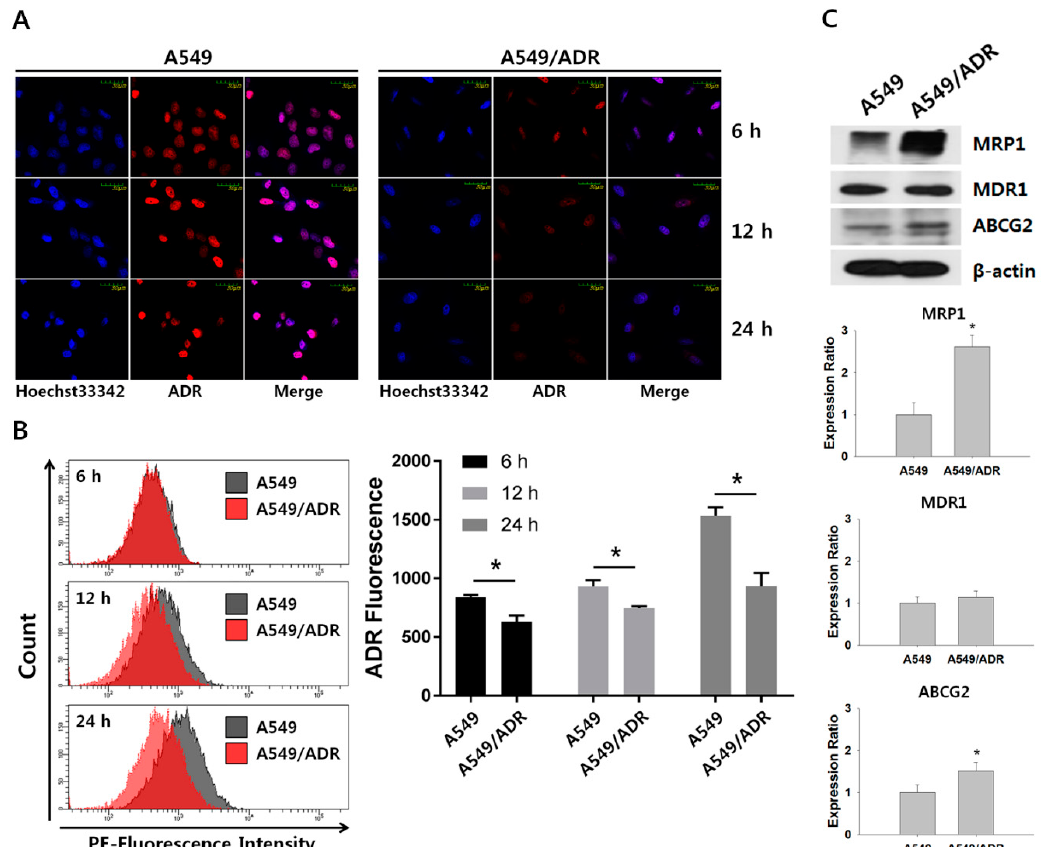
Figure 4. Decrease in intracellular ADR accumulation in A549/ADR cells. ( A ) Representative images of A549 and A549/ADR cells treated with 0.5 µ M ADR (red) for 24 h. ( B ) The histogram shows confocal images of A549 and A549/ADR cells treated with 0.5 μ M ADR (red) for 24 h. ( B ) The the ADR accumulation in A549 cells and A549/ADR cells measured by flow cytometry. ( C ) Expression histogram shows the ADR accumulation in A549 cells and A549/ADR cells measured by flow levels of ABC transporters were analyzed by Western blotting analysis in A549 and A549/ADR cells. cytometry. ( C ) Expression levels of ABC transporters were analyzed by Western blotting analysis in The Western blot intensities were quantified using ImageJ software. * p < A549 and A549/ADR cells. The Western blot intensities were quantified using ImageJ software. * p < 0.05.